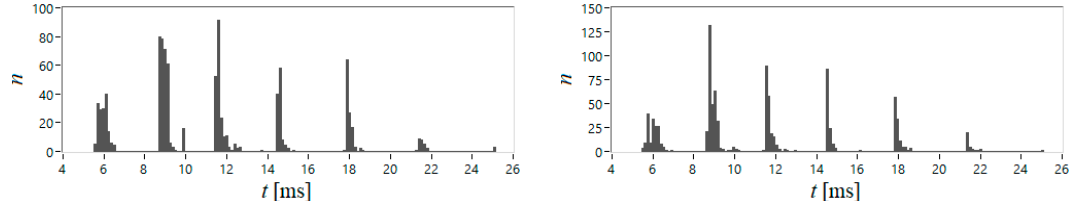
Figure 5. Simulations were conducted on the time interval T = 105 ms with integration step h = 0.01 for all solvers under consideration.